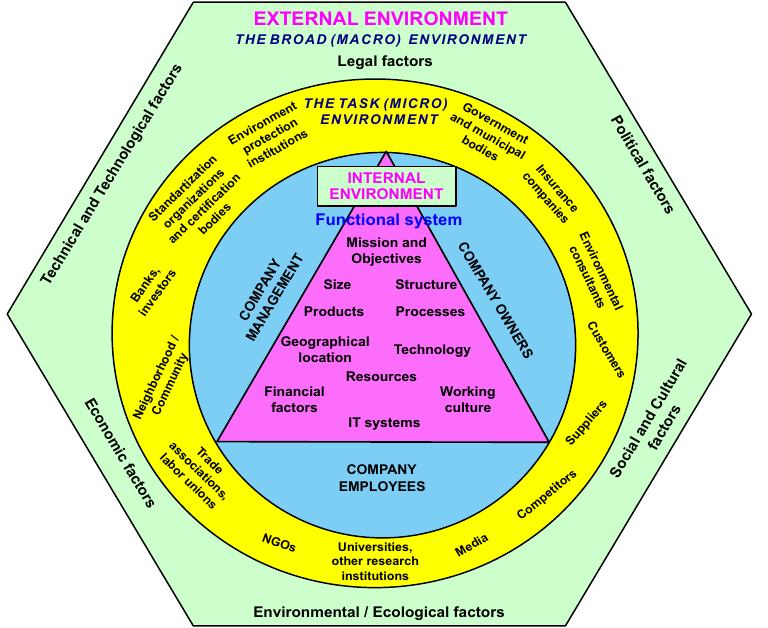
Fig. 2. Company’s external and internal environment